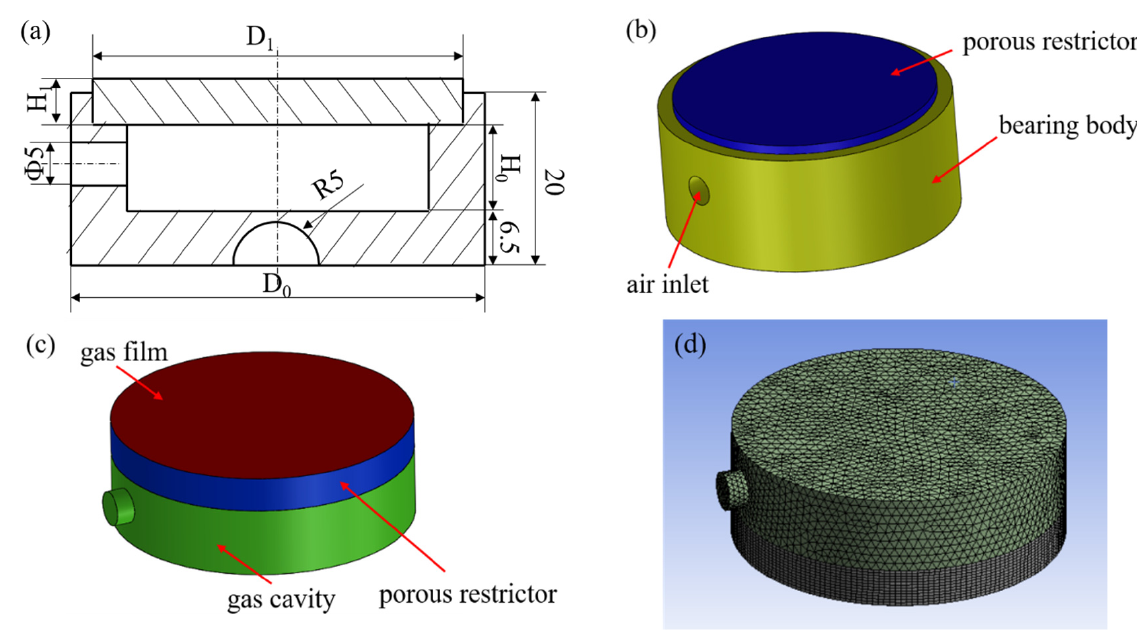
Figure 5. Detail drawing and simulation model of aerostatic bearing: ( a ) detail drawing; ( b ) geometric model; ( c ) fluid model; ( d ) meshing. Table 2. The parameters of the aerostatic bearing.